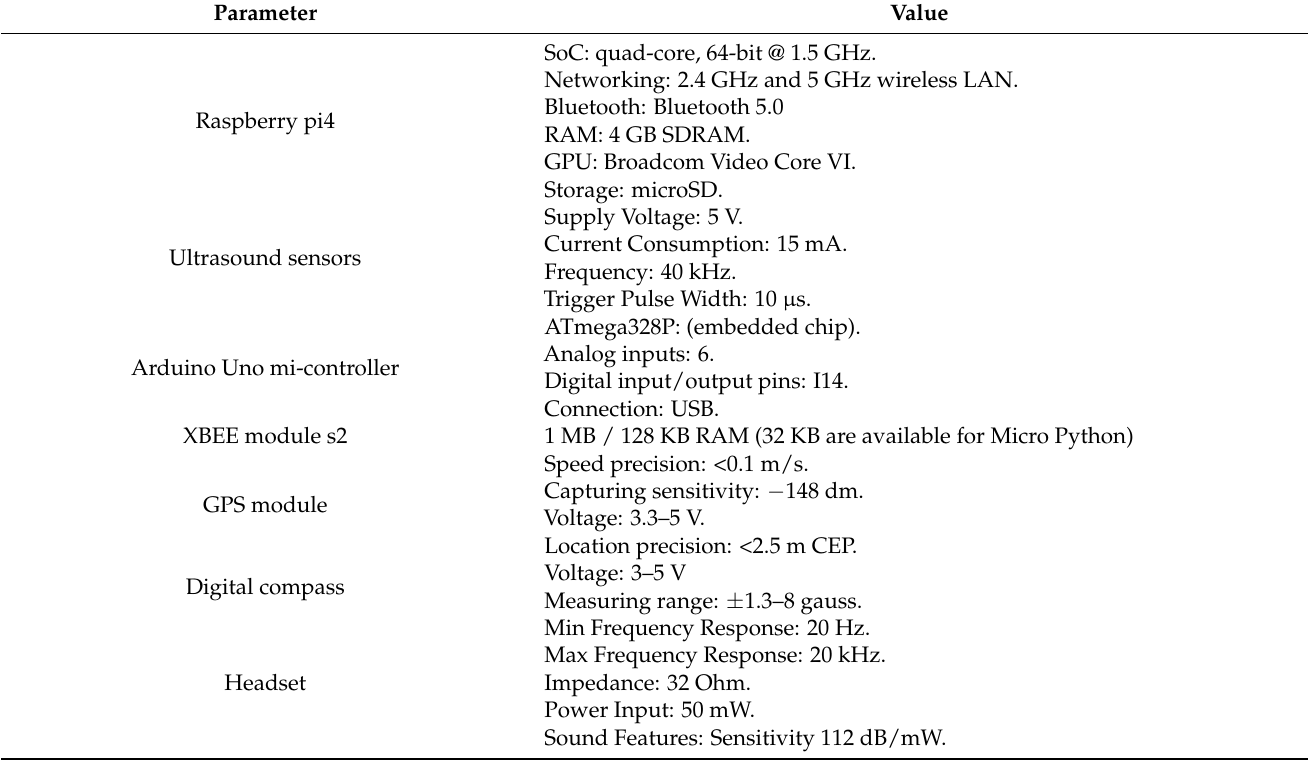
Table A1. The hardware specifications.